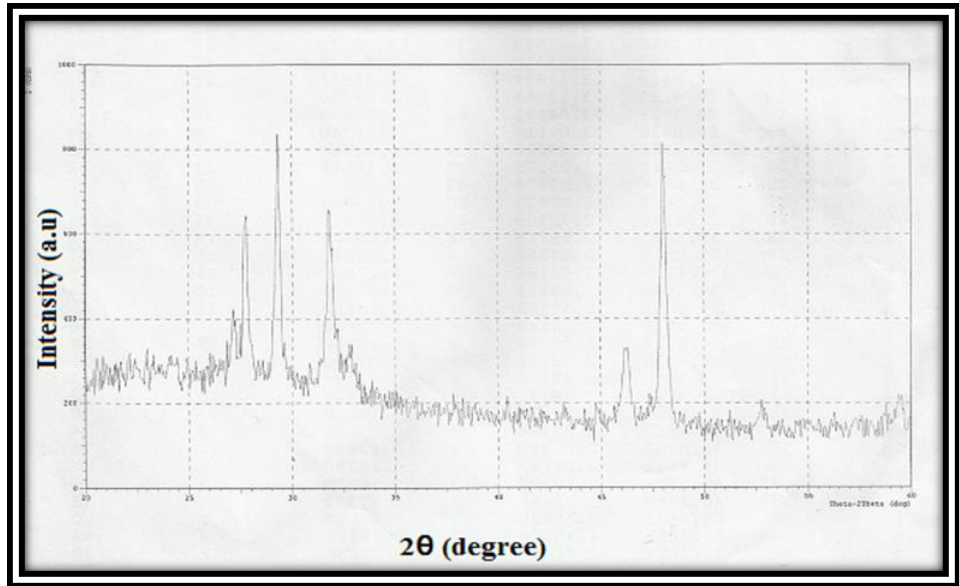
Fig.3: X-ray diffraction pattern of of copper oxide thin film.